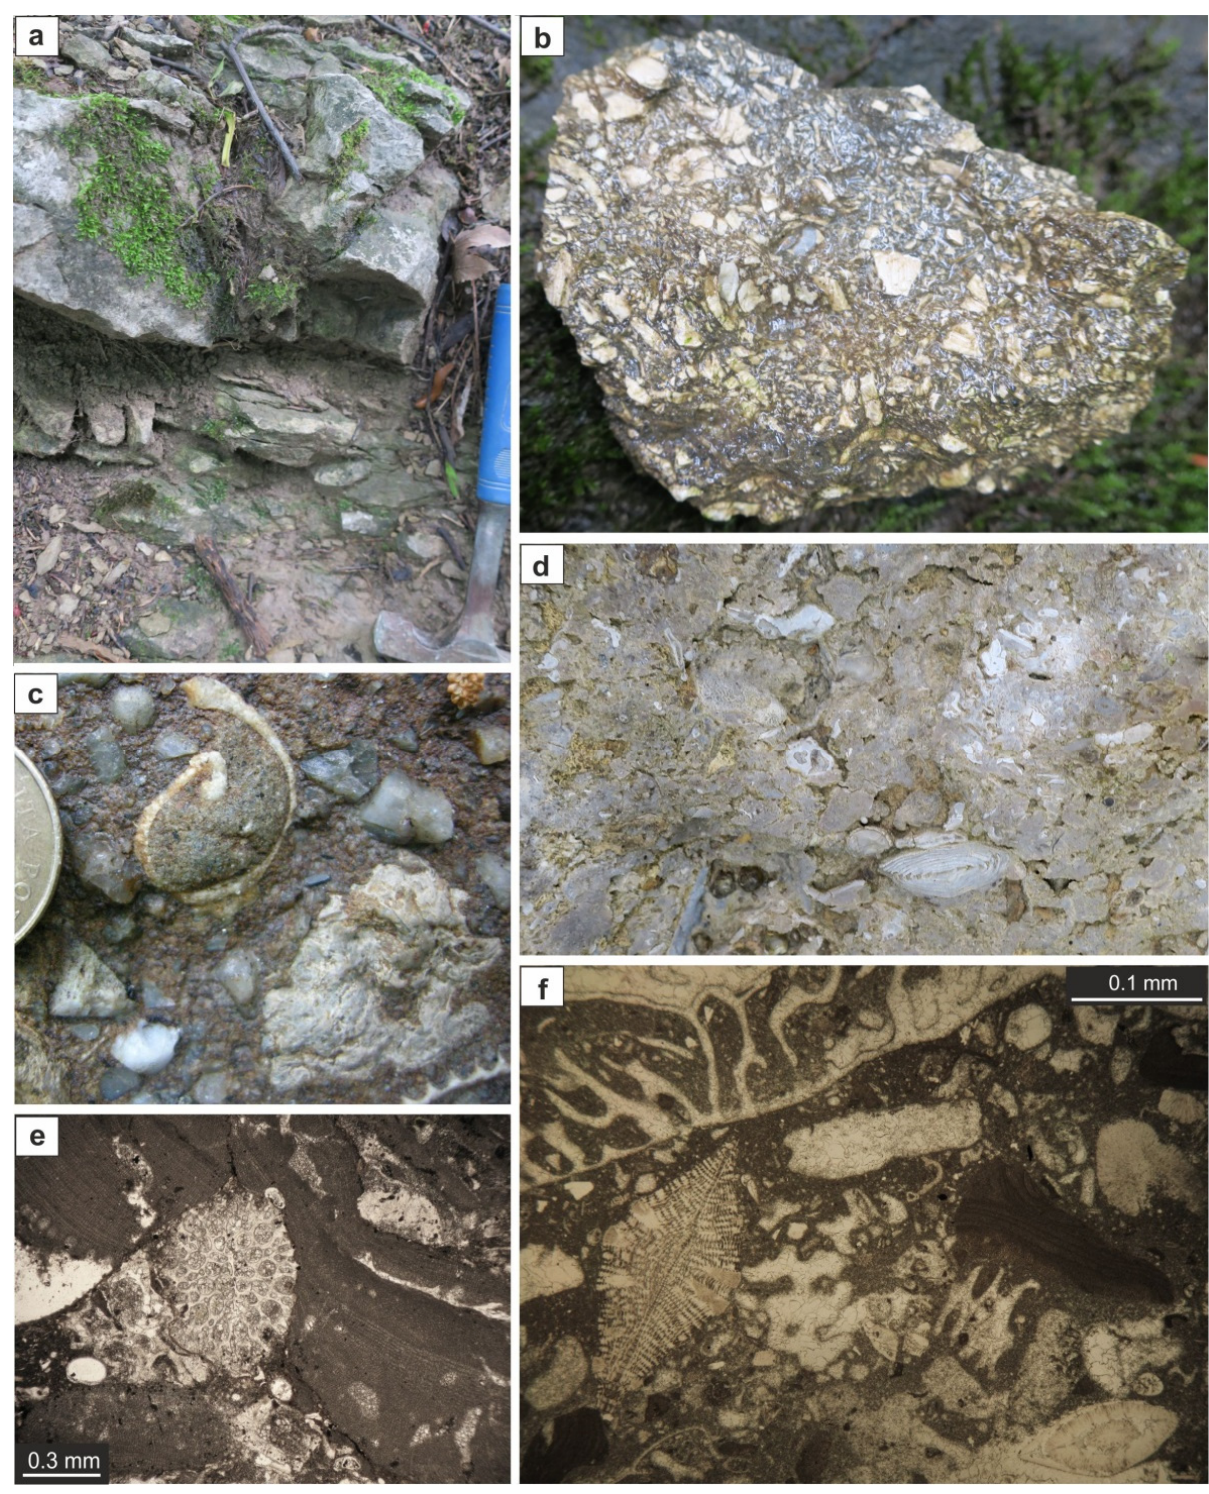
Figure 5. Paleocene–Oligocene carbonate facies: ( a ) the limestone outcrop of the Andrych ó w Klippen (Pa´nska Mt. in Andrych ó w); ( b ) debris flow with bioclasts in Krosno Formation (Bukowiec, Bieszczady Mts.); ( c ) bioclasts in the Ci ęż kowice Formation sandstone (Melsztyn near Zakliczyn); ( d ) limestone block from Eocene olistostrome (Osielczyk stream in Osielec); ( e ) coralline algae–bryozoan boundstone (Targanice Klippe near Andrych ó w); ( f ) packstone with fragments of corals, coralline algae, and large benthic foraminifera (block in Osielec near Rabka Zdrój).